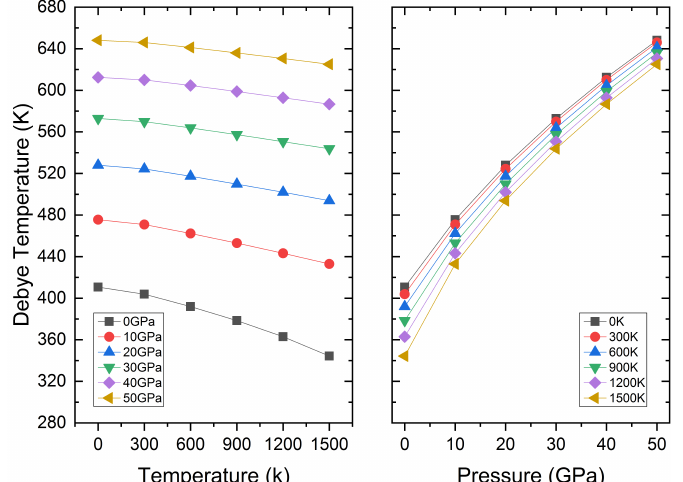
Figure 13. The Debye temperature Θ D variation with temperature ( left ) and pressure ( right ) for Ti 2